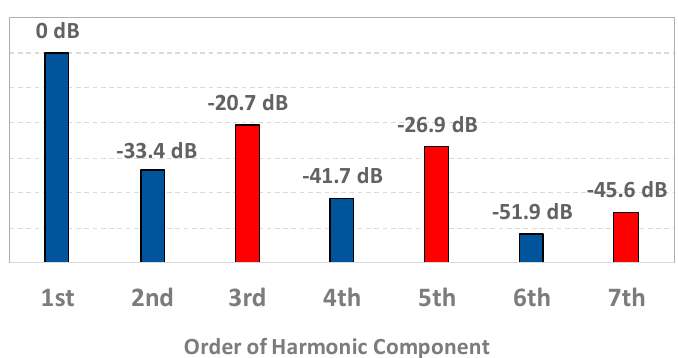
Figure 16. Spectral composition of WPT power over the air-gap, referenced to the first order harmonic.